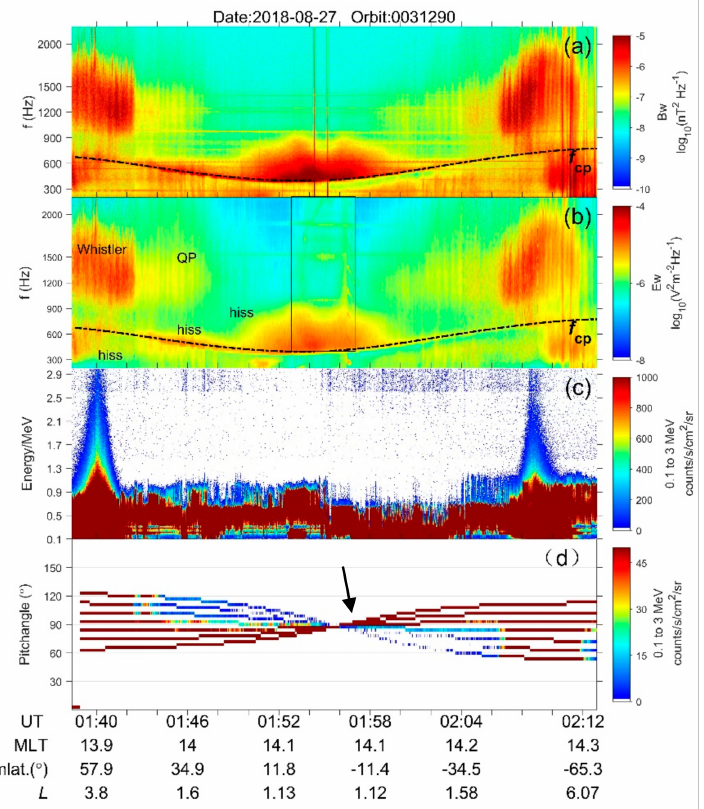
Figure 9. Same as Figure 8 but under disturbed space weather conditions in the nightside ionosphere recorded by orbit No. 0031290 on 27 August